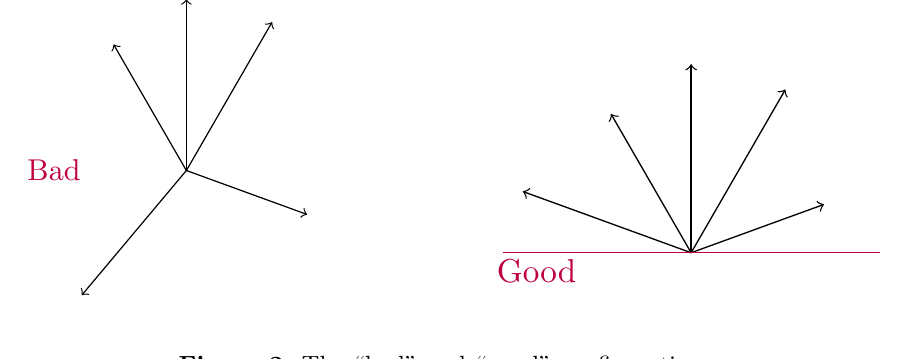
Figure 2 . The \bad" and \good"